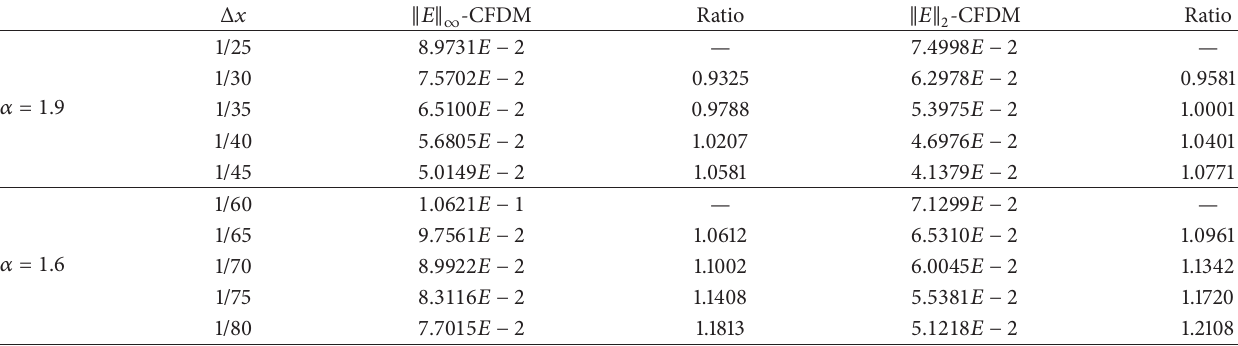
Table 1: The errors and ratios in space calculated by CFDM (12) with 𝑑 = 0.1 and Δ𝑡 = 1/400 at time 𝑡 = 1.5 , for two different fractional orders 𝛼 = 1.9 and 1.6, respectively.